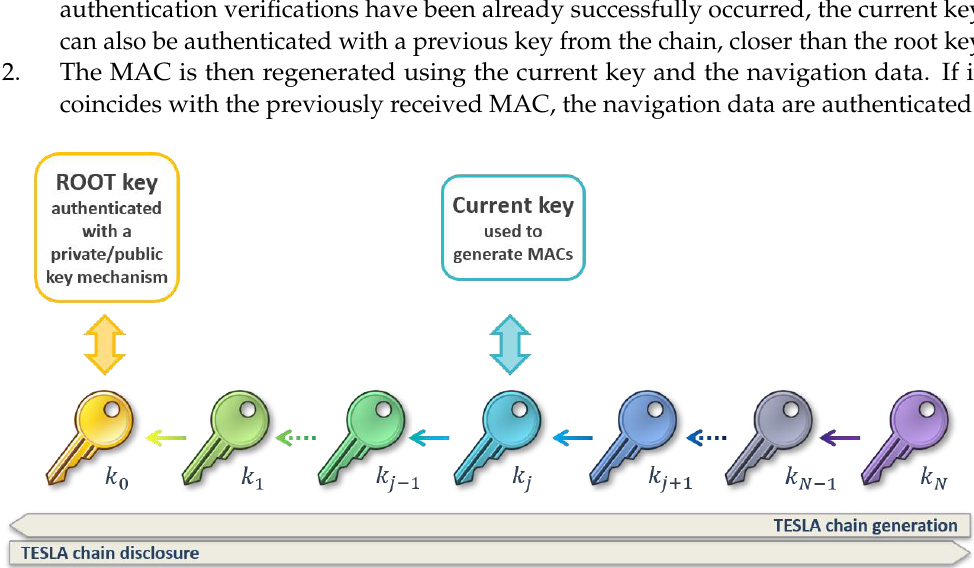
Figure 1. Schematic of the TESLA key chain and its use in the OSNMA